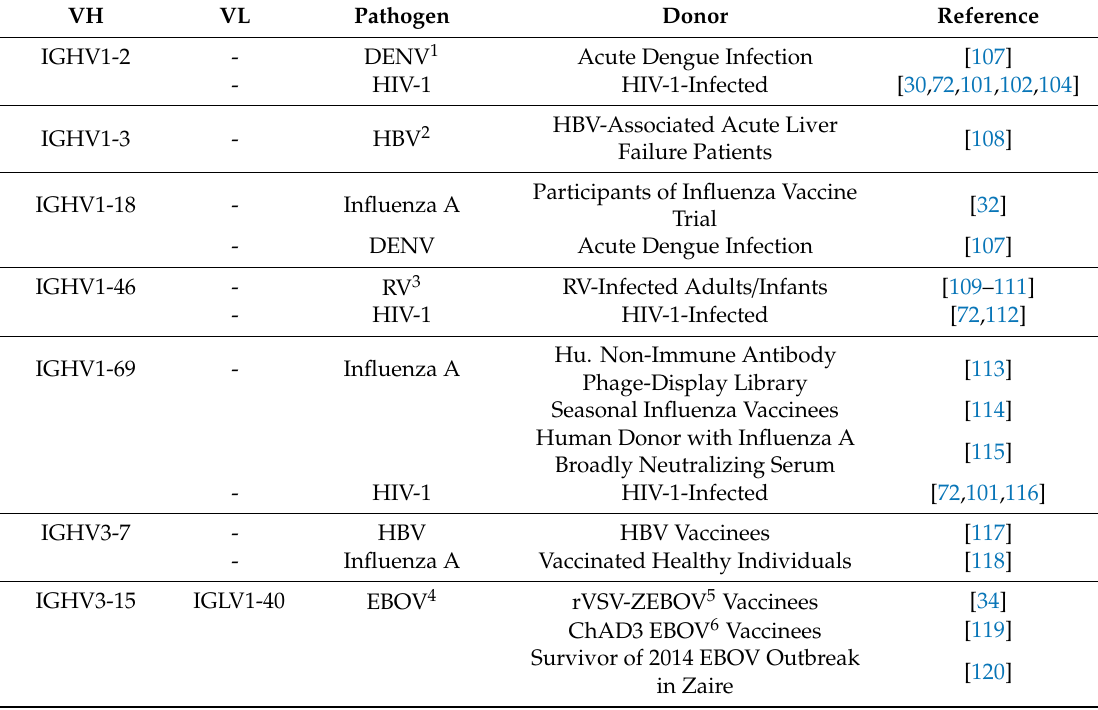
Table 1. Convergent antibody V gene usage in natural infection and in vaccine trials. VH